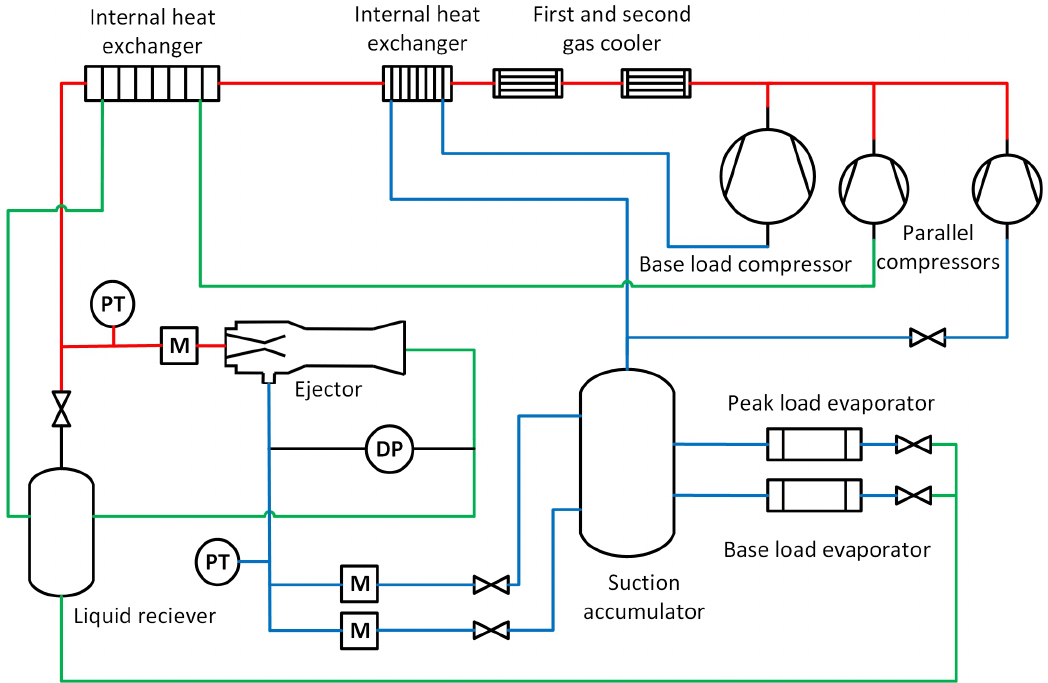
Figure 3. Simplified illustration of the system layout with new ejector and sensors installed. PT—pressure/temperature sensor, DP—differential pressure sensor, M—mass flow